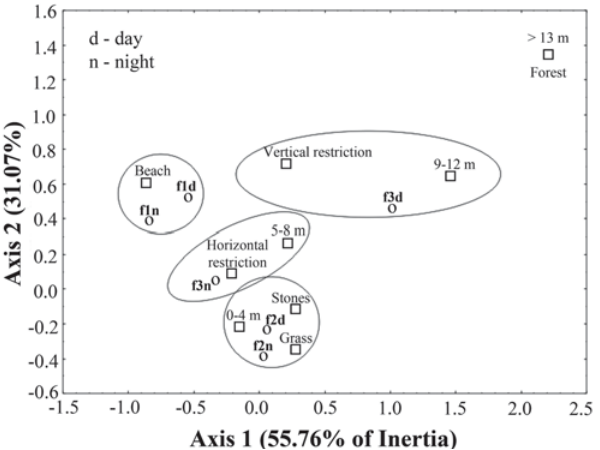
Fig. 4. Graphical representation of the results of a Factorial Correspondence Analysis (FCA): projection in factorial axes 1 and 2 of frequencies of size classes (f1 = DW 15-25 cm, f2 = DW 26-45 cm, and f3 = DW 46-65 cm) of the individuals according to habitat use, regarding period of the day, water depth, type of environment, and vertical and horizontal